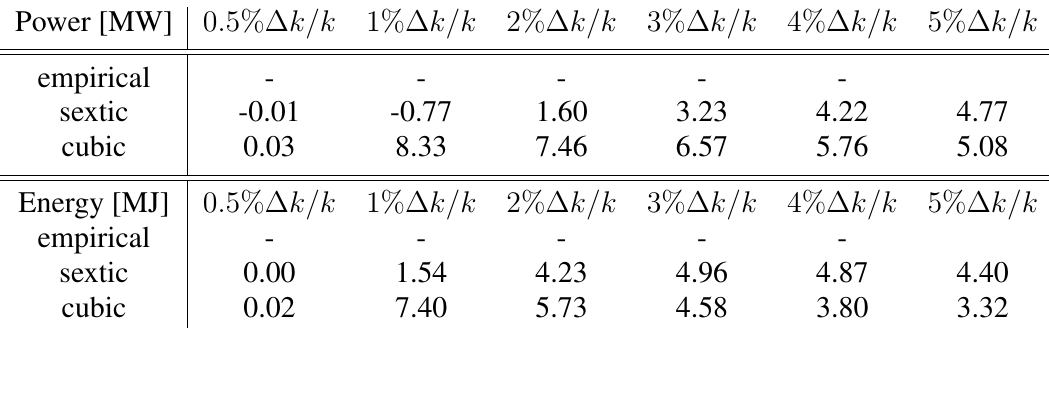
Table 1: % Rel. Diff. in Peak Power [MW] and Core Energy